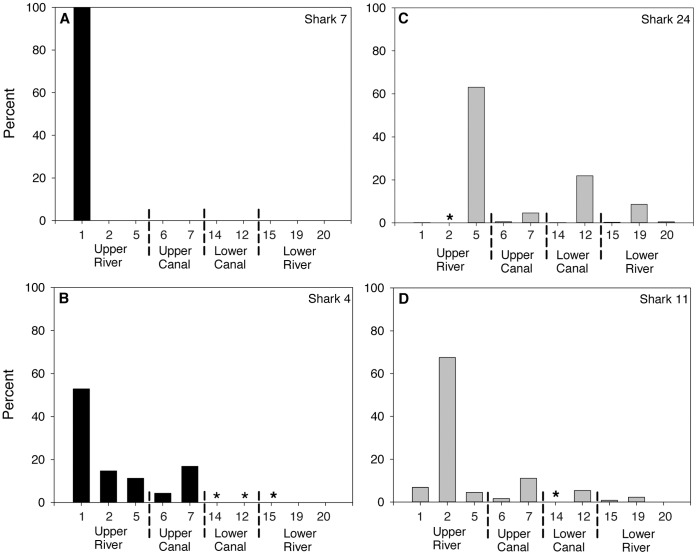
Examples of individual detections across all acoustic receivers for two neonate and two juvenile bull sharks tagged with acoustic tags in the Gold Coast system.Numbers on the × axis refer to individual stations (see Figure 1). Asterisk denotes stations with<5 detections.